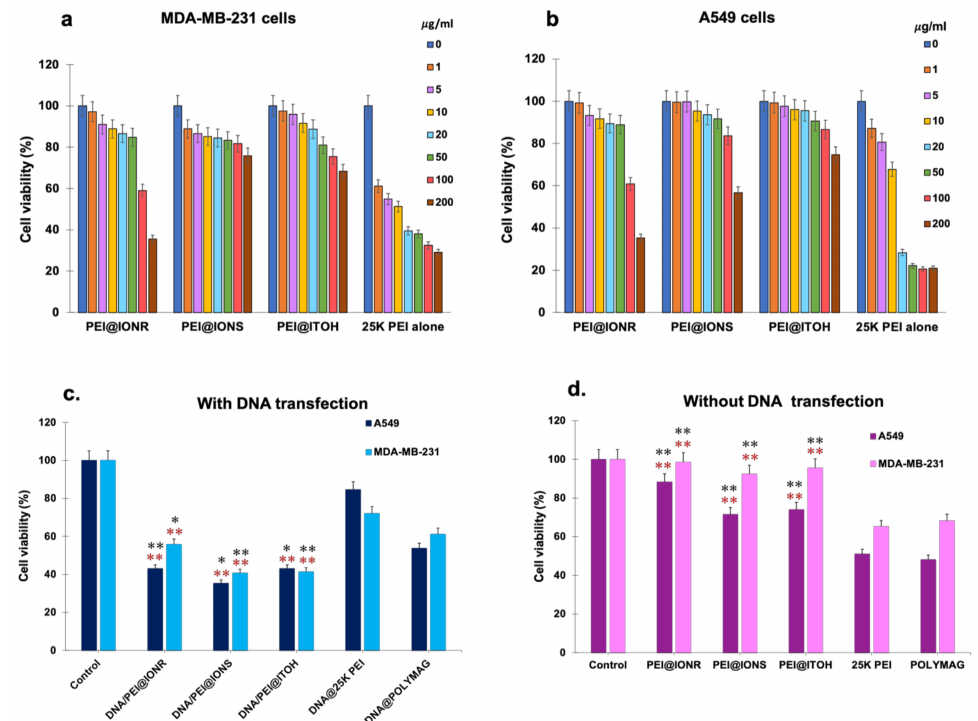
Figure 2. Percentage of cell viability with and without miRNA34a transfection. Cell viability of ( a ) MDA-MB-231 and ( b ) A549 after 48 hours of incubation with PEI-functionalized iron oxide nanoparticles (PEI@IONPs) of different morphologies at different concentrations ranging from 0 to 200 µ g/mL. The percentage of cell viability was compared with the cells alone, i.e., 0 µ g/mL. The data are expressed as mean ± standard deviation ( n = 8). ( c ) The percentage of cell viability after transfection with miRNA34a and without miRNA34a for 48 hours with PEI@IONPs of different morphologies at a weight ratio of 5 ( w/w = 5). After miRNA34a transfection, the percentage of cell viability decreased drastically in the cells treated with PEI@IONPs compared to PEI 25K ( black ) and PolyMag ( red ). ( d ) Without miRNA34a transfection, the cell viability was higher with PEI@IONPs compared to PEI 25K (black ) and PolyMag ( red ). The data are expressed as mean ± standard deviation ( n = 3, * p < 0.05, ** p <